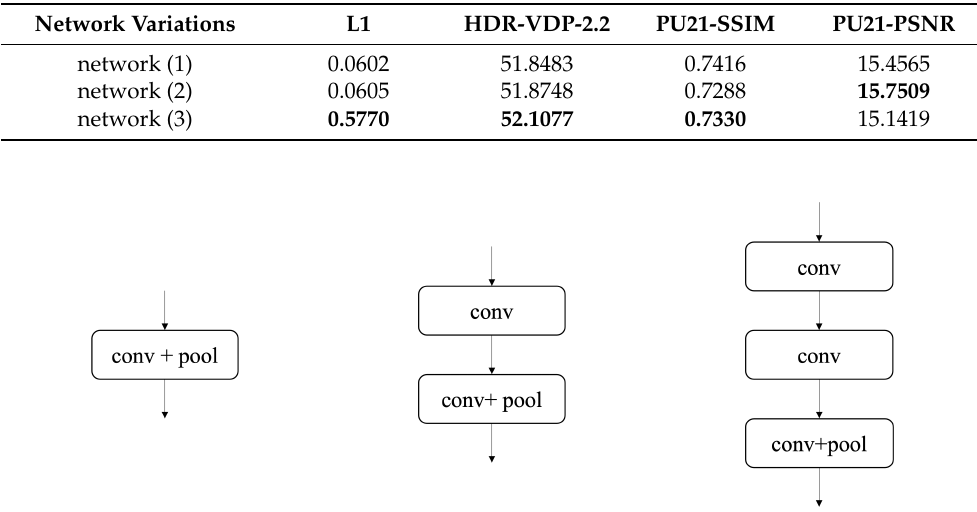
Table 2. The test results for networks (1), (2), and (3) shown in Figure 10. The values in bold indicate the best scores for each metric.